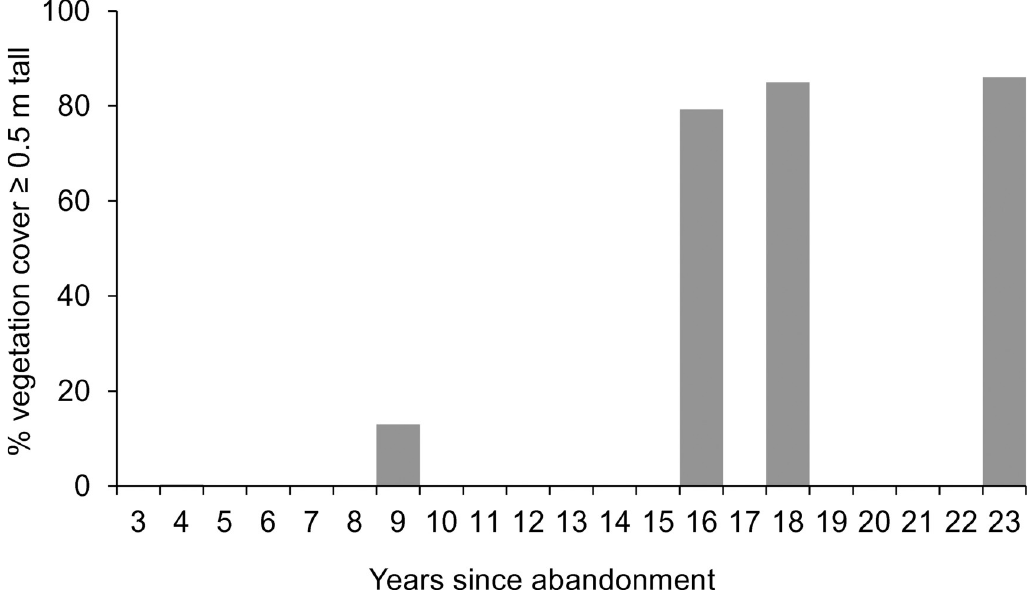
Fig 3. New Wilderness vegetation cover. Progressive coverage of vegetation of at least 0.5 m tall in the New Wilderness in the years since abandonment in